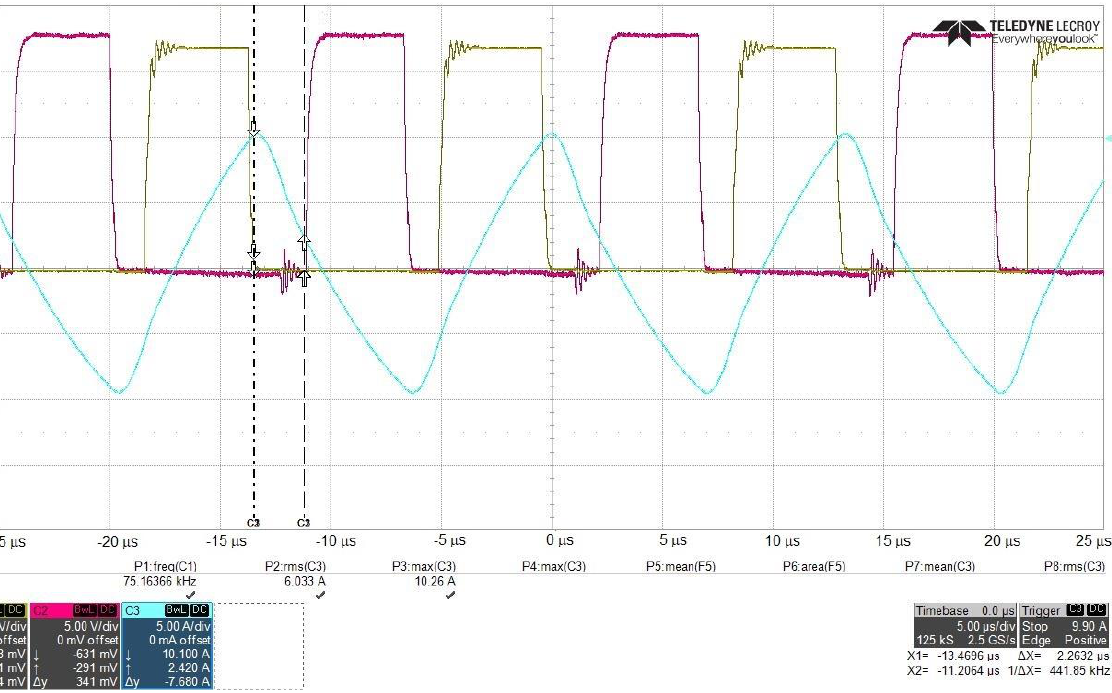
Figure 32. High-side IGBT control signal (C1, green), low-side IGBT control signal (C2, purple), and transmitter coil current (C3, blue) at 75 kHz.